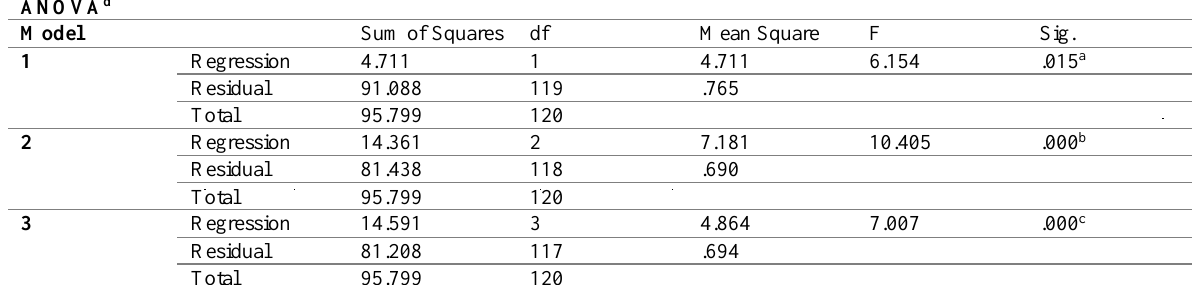
Table 4: Anova Results and